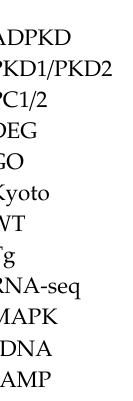
Figure S1. Representative schematic of the PKD2 overexpression vector. A. The PKD2 overexpression vector can be readily used as a targeted integration transgenic vector when cotransfected with a CRISPR / Cas9 vector targeting the pig H11 locus. Three point mutations (c.A1532T / p.D511V, c.T1967G / p.L656W, and c.C2224T / p.R742X) for Tg1-3, respectively, are shown in solid blue lines above hPKD2 . B. Representative alignment results of WT, Tg1, Tg2, and Tg3 PKD2 sequences. Mismatched sites are highlighted in yellow. Figure S2. Western blot analysis of PC2 (left panel) and MYC (right panel) expression in aging transgenic pigs showing similar expression levels of the proteins. Tg-P, the cloned pig with positive integration of exogenous gene; Tg-N, the cloned pig with negative integration of pig PKD2 . Red arrows indicate the location of corresponding bands of PC2 and MYC. Figure S3. MA plots comparing the four genotype models with the control model. The blue nodes represent DEGs, while the green nodes represent genes that had p -values of less than 0.05 but did not satisfy the FC cuto ff criterion. The triangles represent values that exceed the axis ranges of the graph. The node size varies with the magnitude of the | FC | value, Table S1. Oligos used in the study, Tables S2–S5. DEGs between the four di ff erent genotype models and the control model, Tables S6–S9. GO terms significantly enriched in DEGs of the four di ff erent genotype